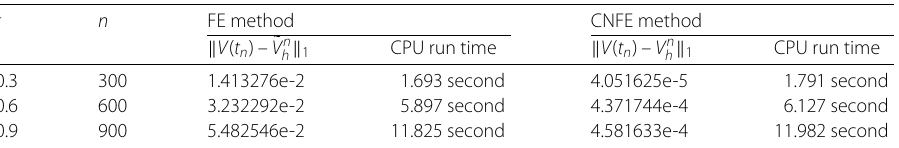
Table 1 The CPU elapsed time and the relative errors of the FE and CNFE solutions t